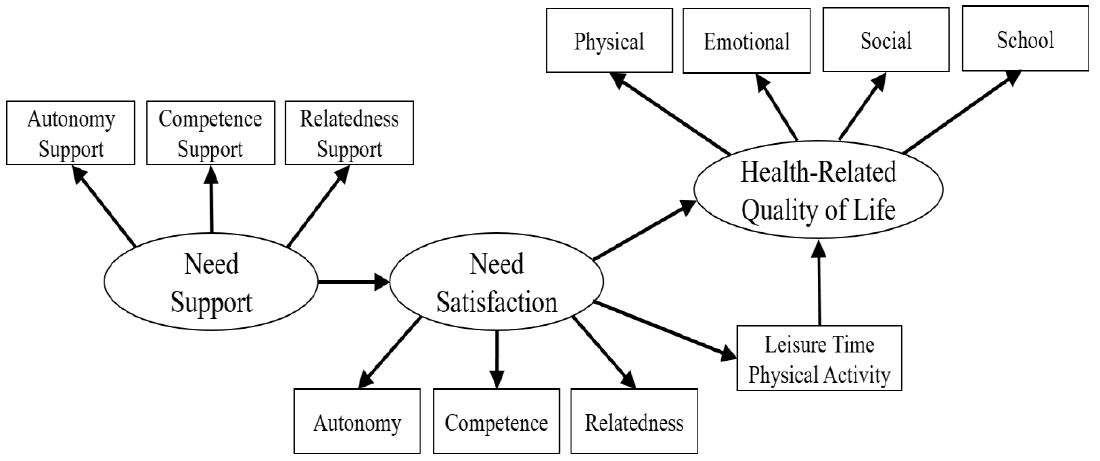
Figure 1. Hypothesized Model of the Variables. Note. Circles represent latent variables, and squares represent observed variables.